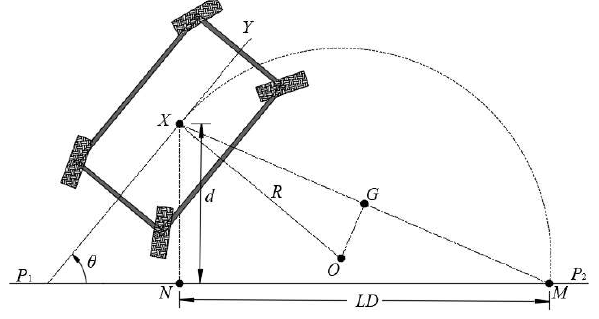
Figure 4. Pure pursuit model.